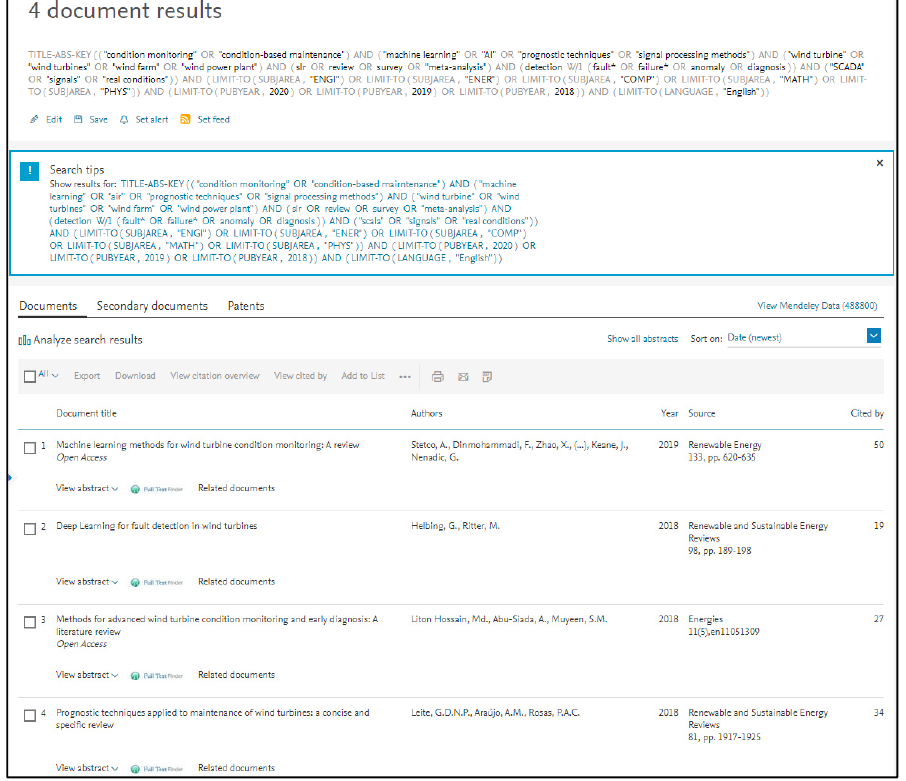
Table 3. Summary of findings and limitations in relation to the research questions formulated.